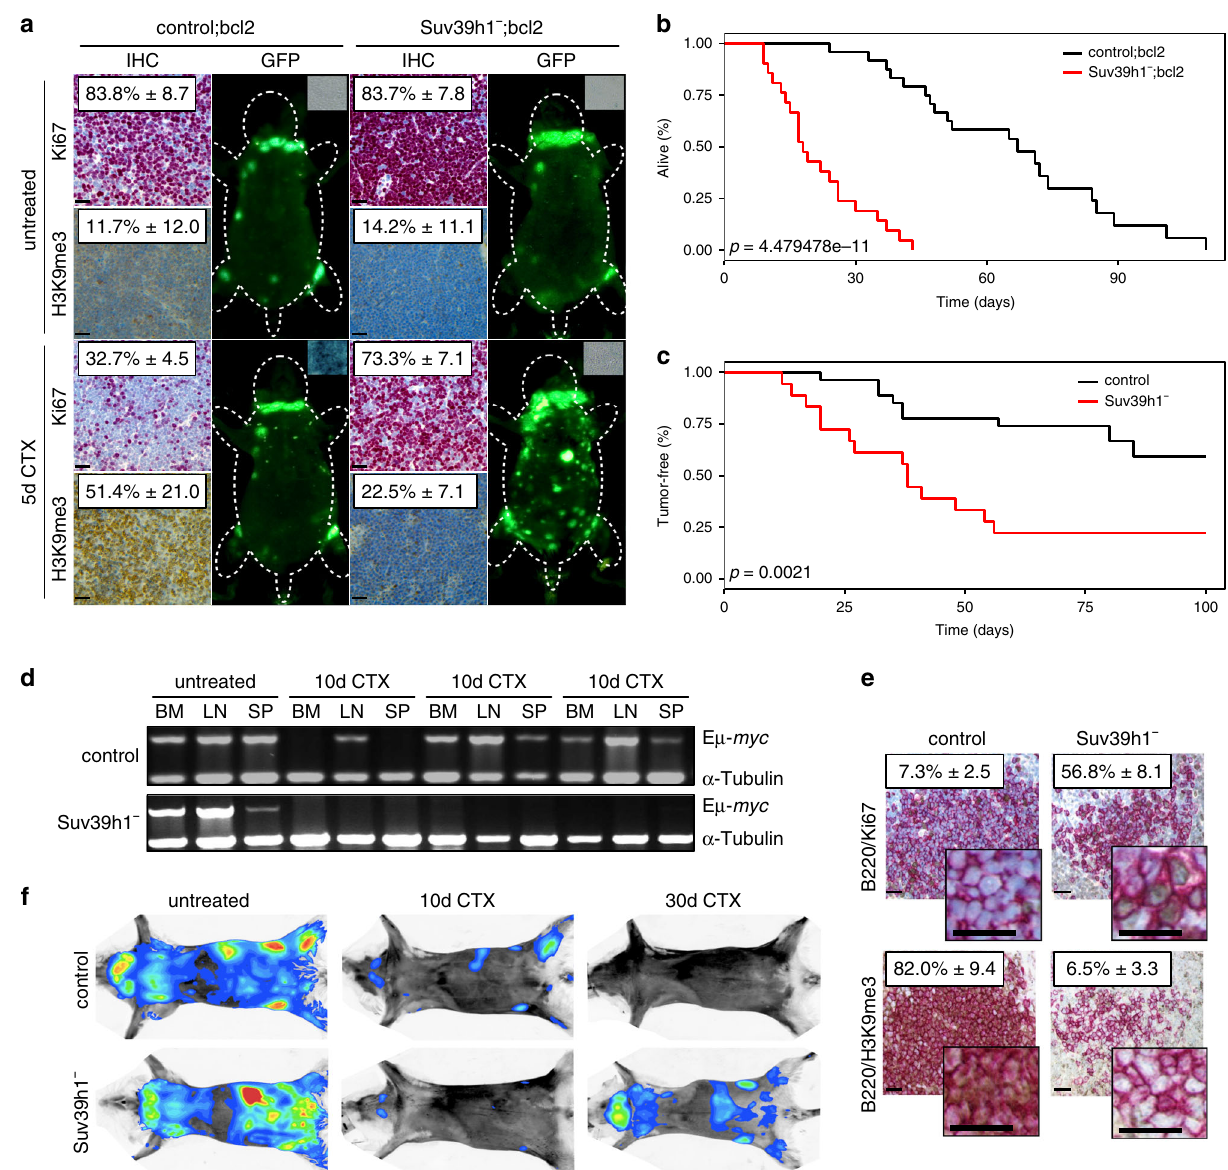
Fig. 3 Defective senescence but intact apoptosis accounts for temporarily deeper responses of Suv39h1-de fi cient lymphomas. a Ki67, SA- β -gal activity and H3K9me3 IHC analyses of lymphoma sections, plus whole-body fl uorescence scans of mice bearing GFP-tagged control;bcl2 or Suv39h1 − ;bcl2 lymphomas. Results show mean percentages of cells positive for the respective markers in situ after a 5-day CTX exposure or those that remained untreated ± s.d. ( n = 3 technical replicates per group). b Overall survival of mice bearing Suv39h1 − ;bcl2 ( n = 21, red line) or control;bcl2 ( n = 24, black line) lymphomas after CTX treatment. c Tumor-free survival (i.e., TTR) of mice bearing Suv39h1 − ( n = 18, red line) or control ( n = 27, black line)